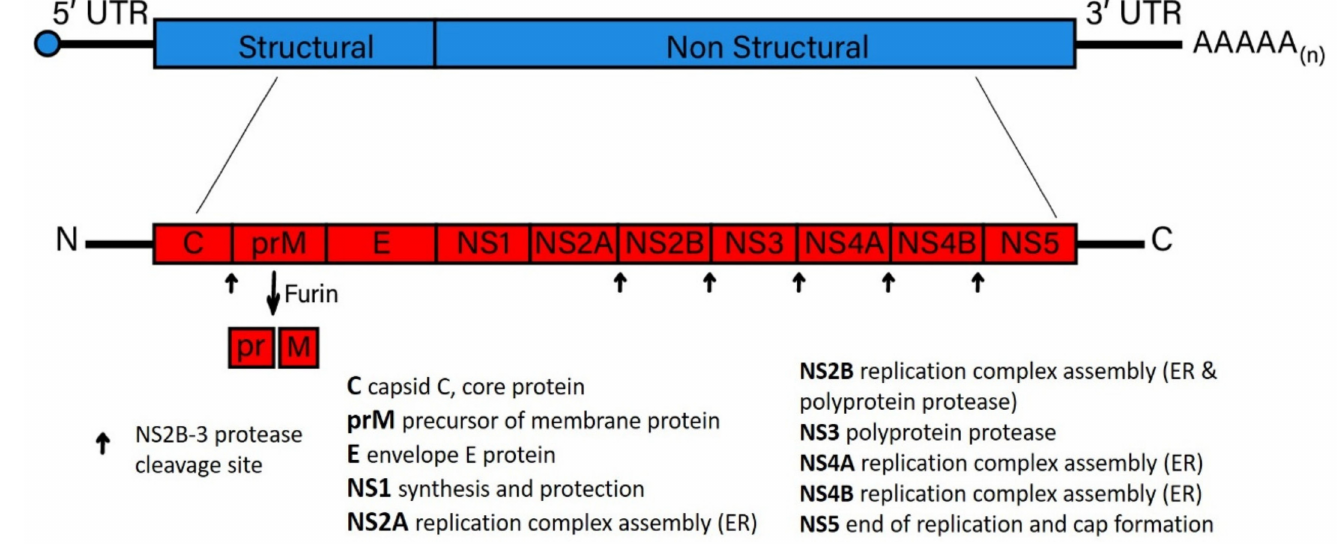
Figure 3. Schematic Diagram of the Vector-borne Flavivirus Genome. A representation of the approximately 11 kb flavivirus genome (in blue), capped and polyadenylated, and subsequent translation protein products (in red) are shown to illustrate the important flavivirus replication functions. These features and functions are consistent between tick-borne and mosquito- borne flaviviruses. Functions of the flavivirus genes as they pertain to the establishment of viral persistence in host cells are described in the text. UTR = untranslated region, AAAAA(n) =